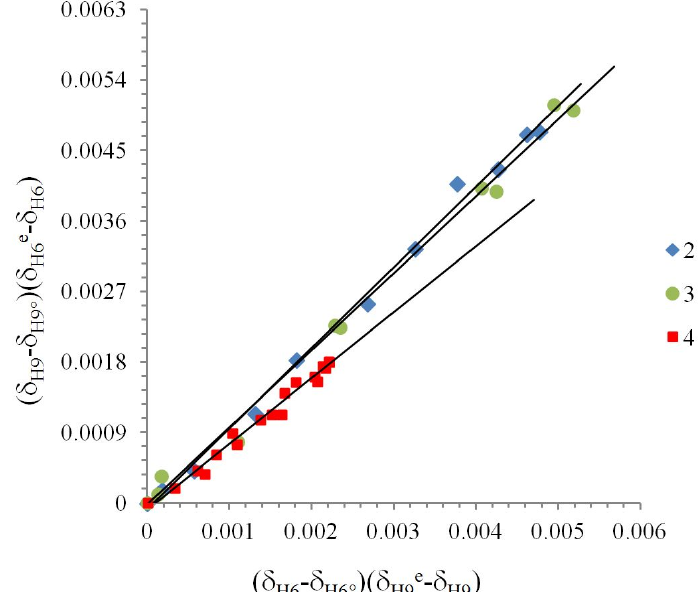
− δ )( δ H6e − δ ) = Δ K ( δ − δ )( δ H9e − δ ), Δ K is the H9 H9° H6 NHO H H6° H9 NHO